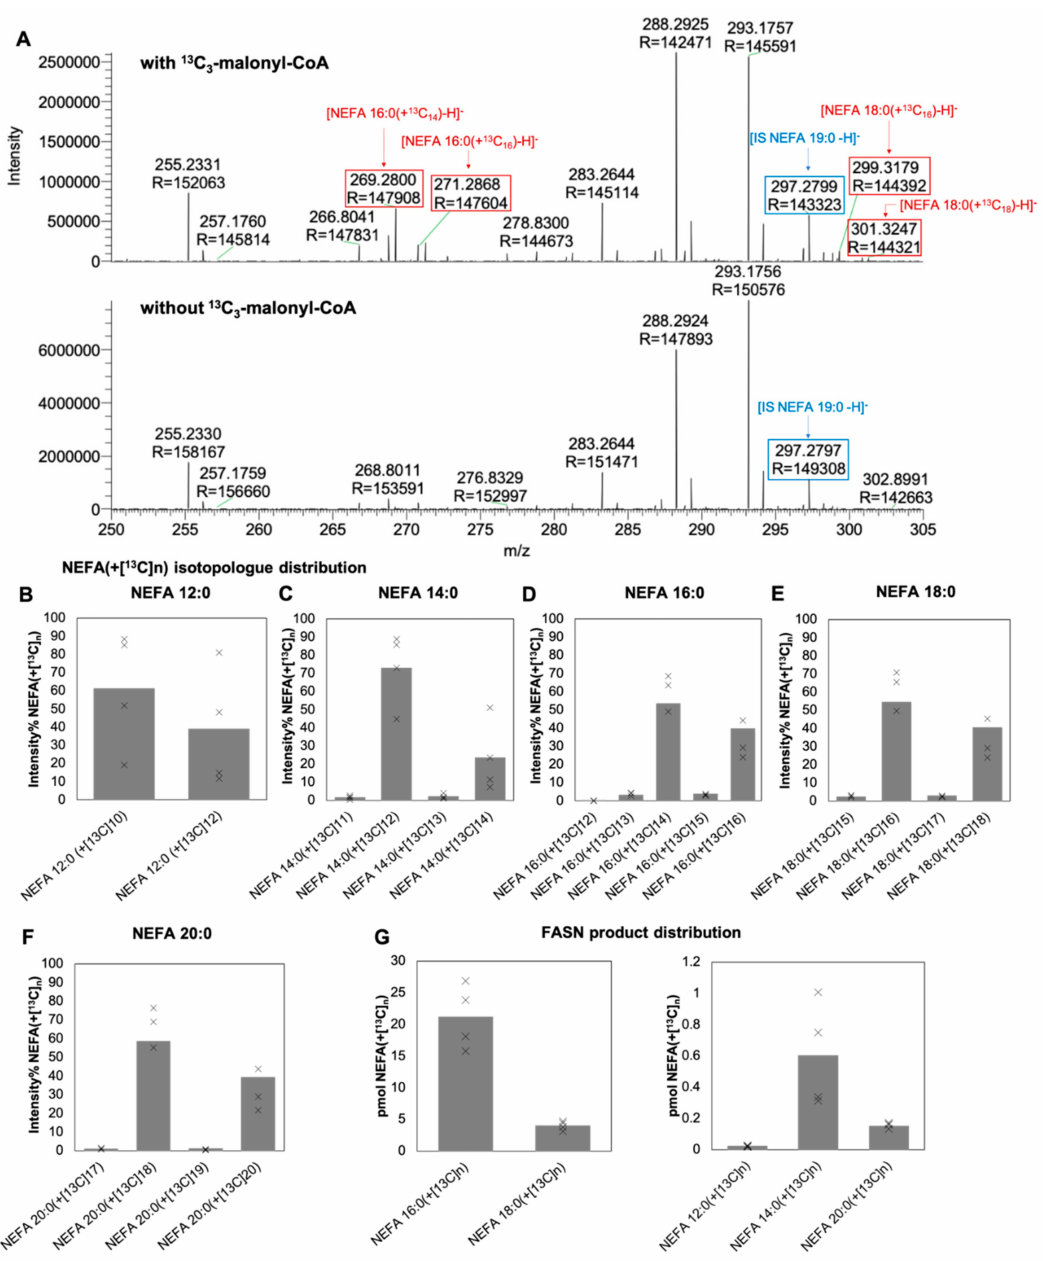
Figure 1. Specific monitoring of de novo synthetized 13 C-labeled NEFAs. ( A ) Negative ion mode Fourier transform mass spectrometry (FTMS) analysis of deprotonated 13 C-labeled NEFA analytes. Purified fatty acid synthase complex (FASN) was incubated with 13 C 3 -malonyl-CoA, acetyl-CoA and NADPH (top panel) or acetyl-CoA and NADPH (lower panel) at 37 ◦ C for 10 min. Subsequently the reaction mixtures were subjected to total fatty acyl (FA) analysis [26] using acid-catalyzed hydrolysis in the presence of internal 19:0-CoA standard, followed by extraction with hexane and FTMS analysis using an LTQ Orbitrap XL mass spectrometer. Ions representing the internal standard are indicated in blue, while detected 13 C-labeled NEFAs are indicated in red. The abundant ions at m / z 288.2925 and 293.1757 are due to non-interfering chemical background noise. ( B – F ) 13 C isotopologue distribution of indicated NEFA species. Data represent average values and dots individual measurements ( n = 4 independent reactions extracted and analyzed separately). ( G ) Average pmol of de novo synthetized 13 C-labeled NEFA per µ g FASN per 10 min. Data represent average values and dots individual measurements ( n = 4 independent reactions extracted and analyzed